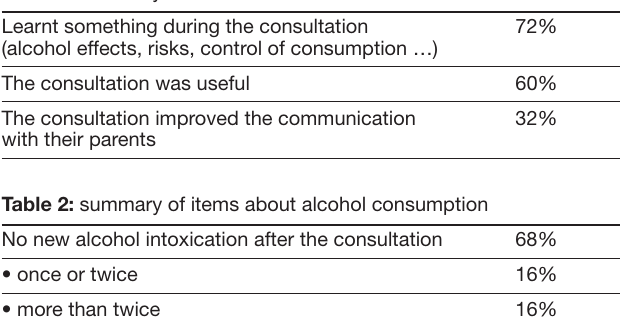
Table 1: summary of items about the consultation